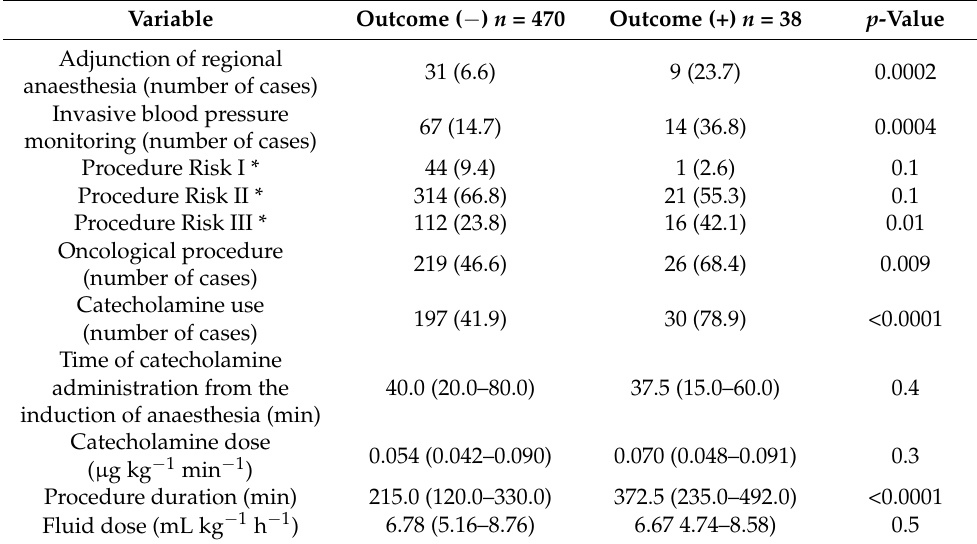
Table 2. Intraoperative population characteristics.